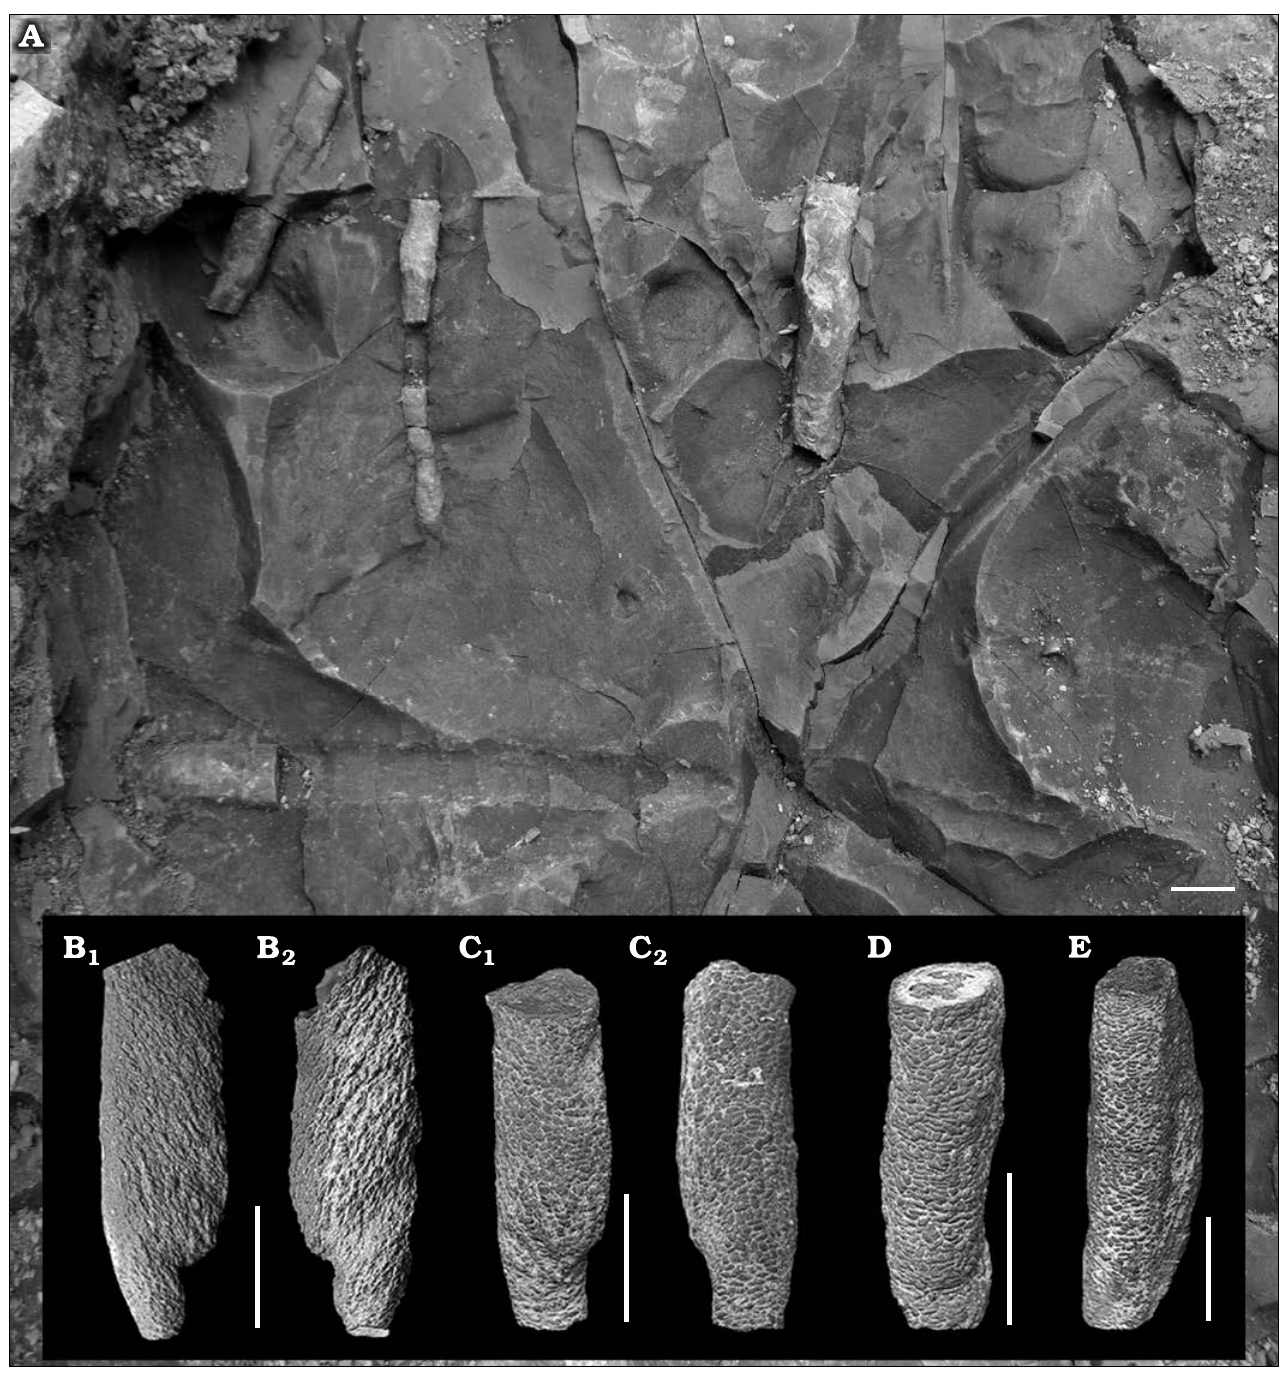
Fig. 4. Simple, actively filled (pelletoidal) horizontal to oblique structure Tubulichnium mediterranensis (García-Ramos, Mán gano, Buatois, and Rod- rí guez-Tovar, 2014), from Velká nad Veličkou, Czech Republic, Eocene. A . Field photo of in situ specimens. B – E . MZM Ge 32958, partially preserved burrows with clearly visible spindle-like shape and pelletal infill. Same specimens from different angles (B 1 and B 2 ; C 1 and C 2 ). Scale bars 10